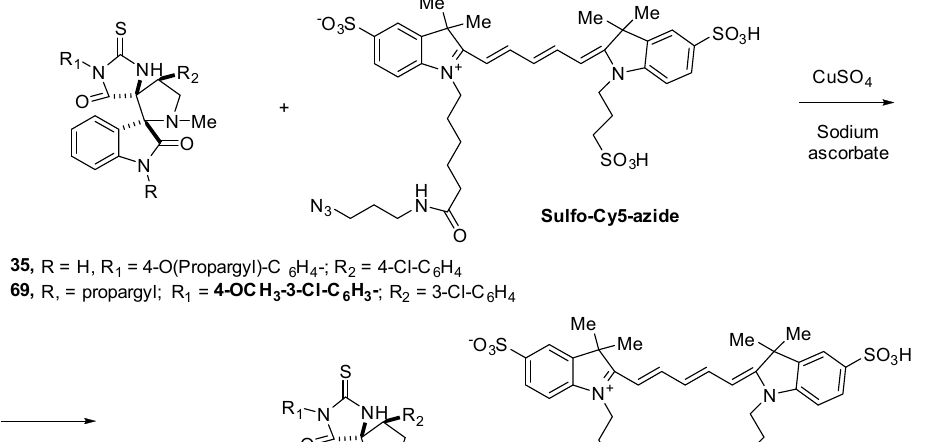
Scheme 2. Click reaction between the fluorescent dye Sulfo-Cy5-azide and dispiro -indolinones 69 and 35 .